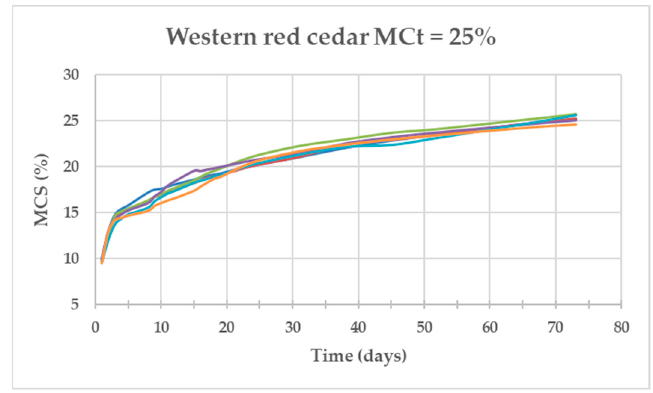
Figure 4. Evolution of the MC of the six Western red cedar specimens as a function of time for MCt = 25%.